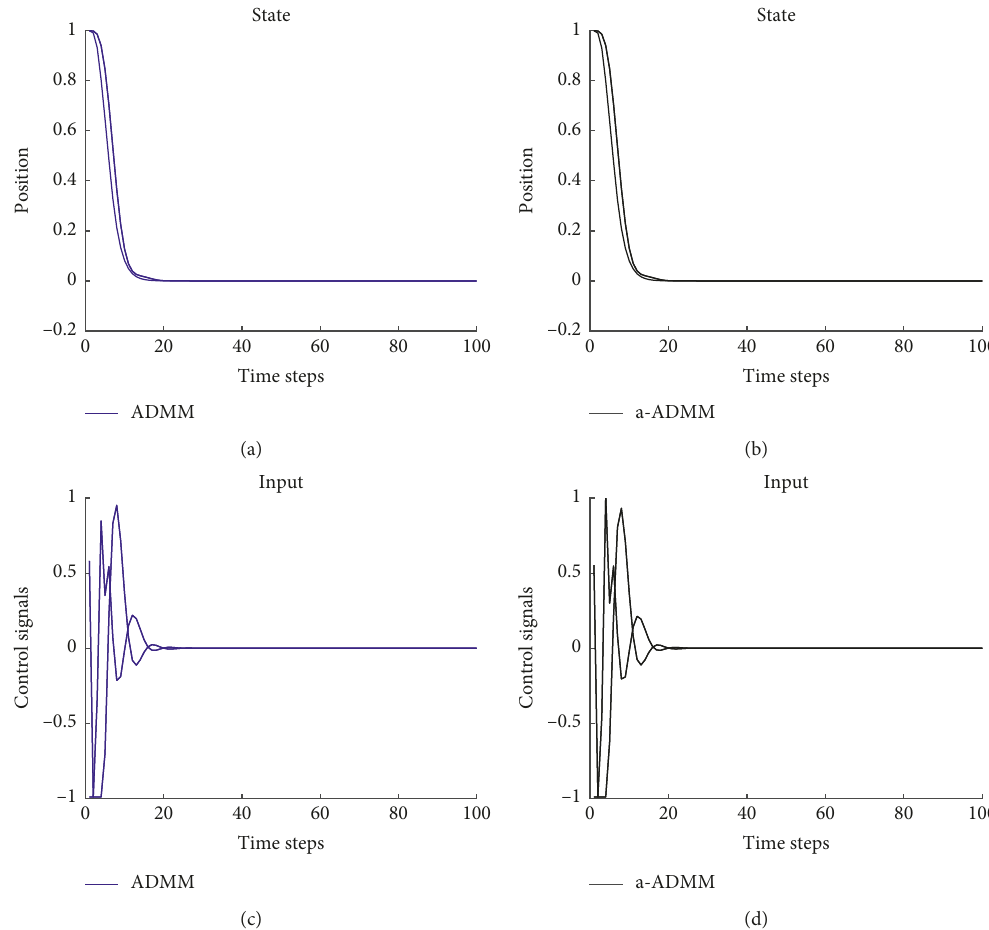
Figure 3: Closed-loop performance (running time on y -axis) versus number of time steps (time steps on x -axis) of ADMM and a-ADMM on UAV control task with N �